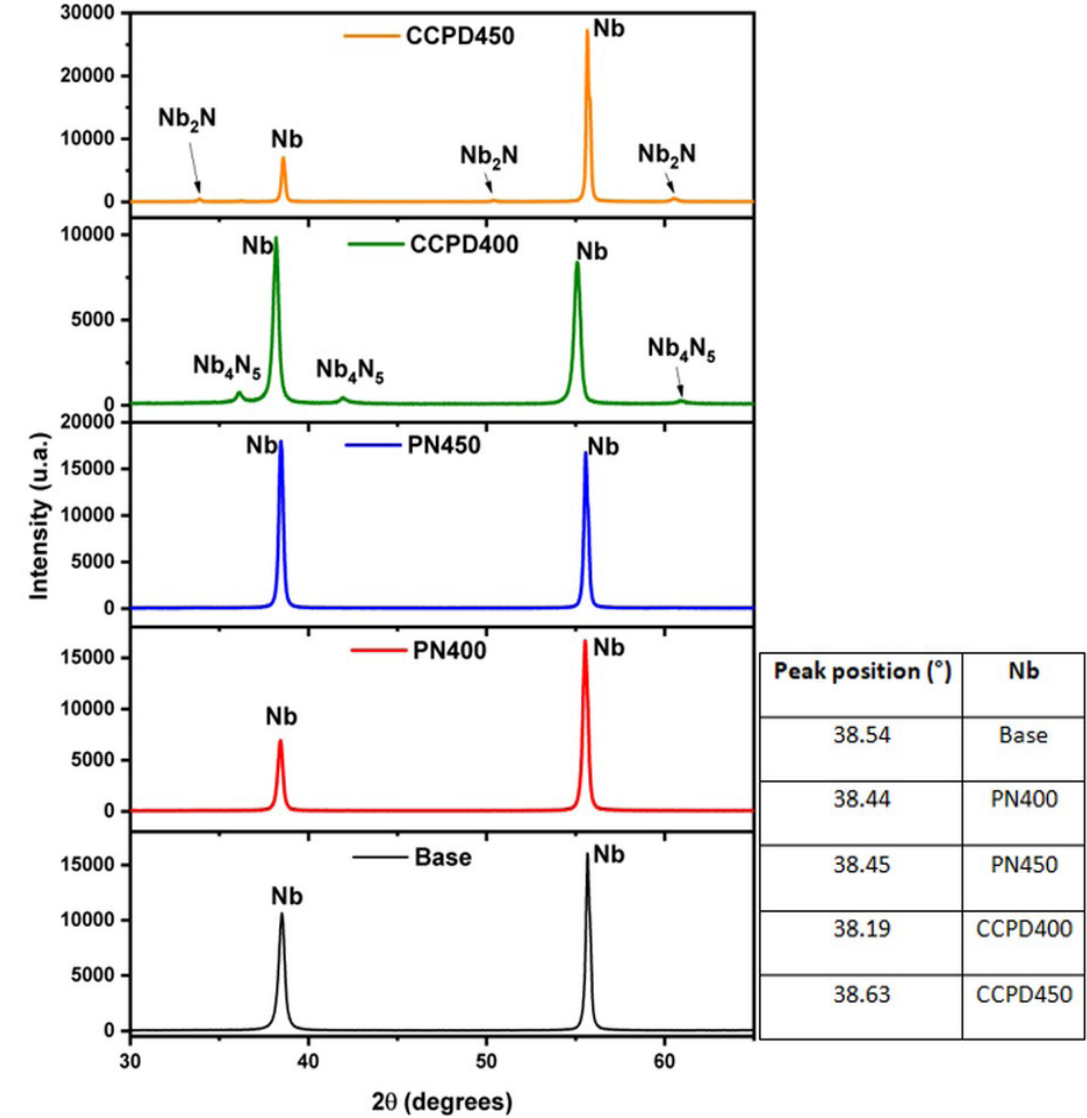
Figure 1. X-ray diffractogram and the 2θ position of the 100% peak.